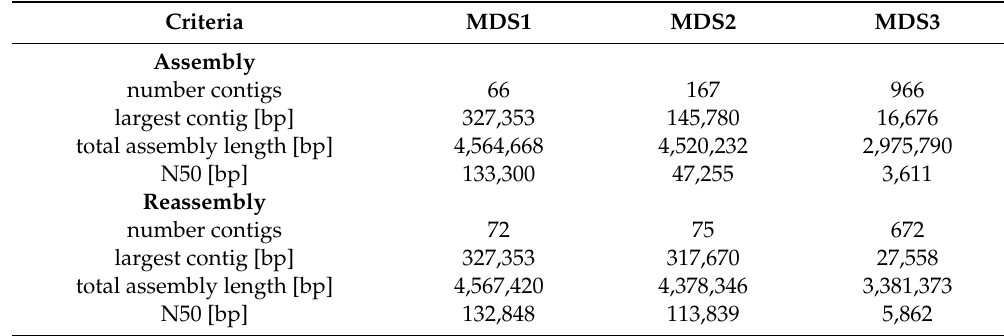
Table 4. Comparing assembly and reassembly